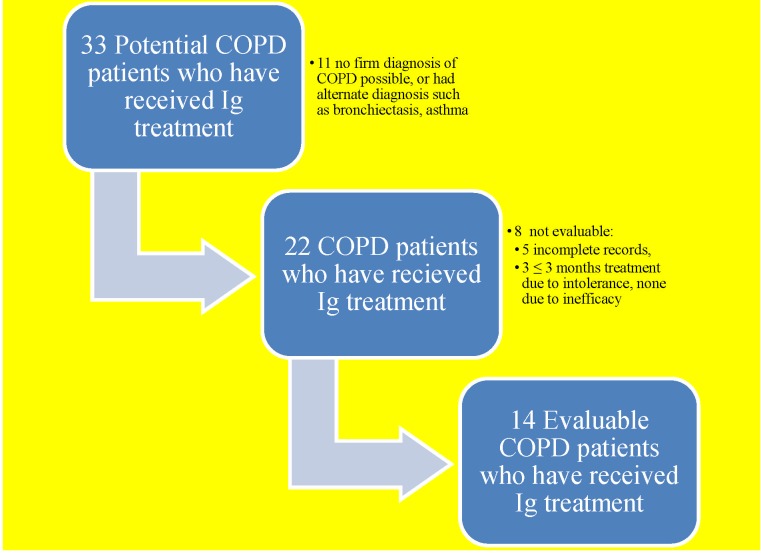
Flowchart of study population identified for analysis.